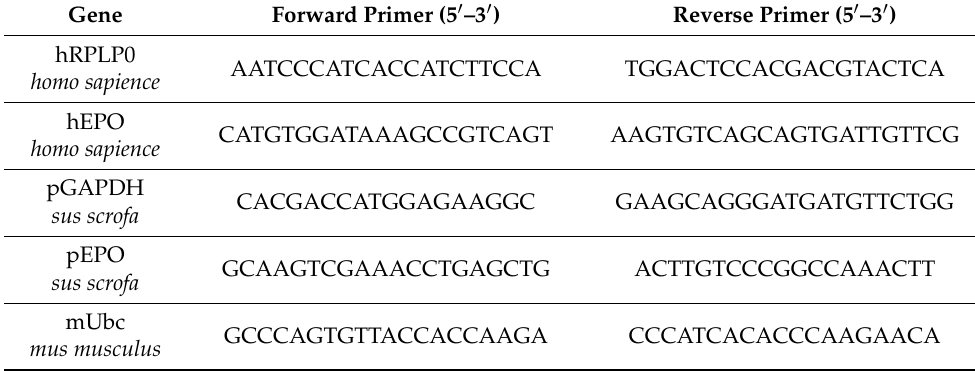
Table 1. Primers used for qPCR